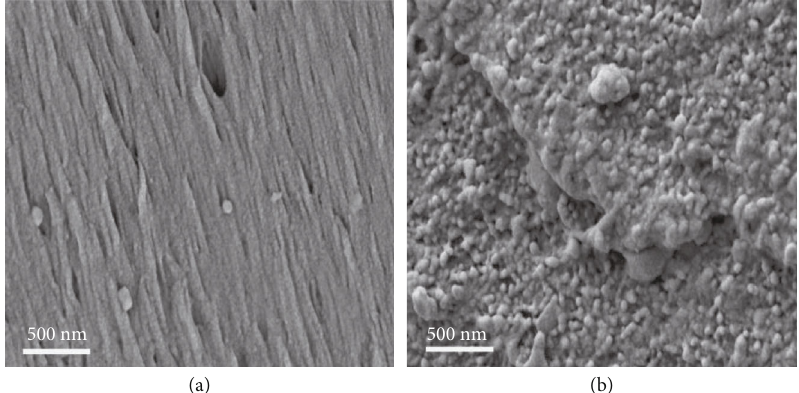
Figure 5: SEM image of pure bu ffi ng dust and